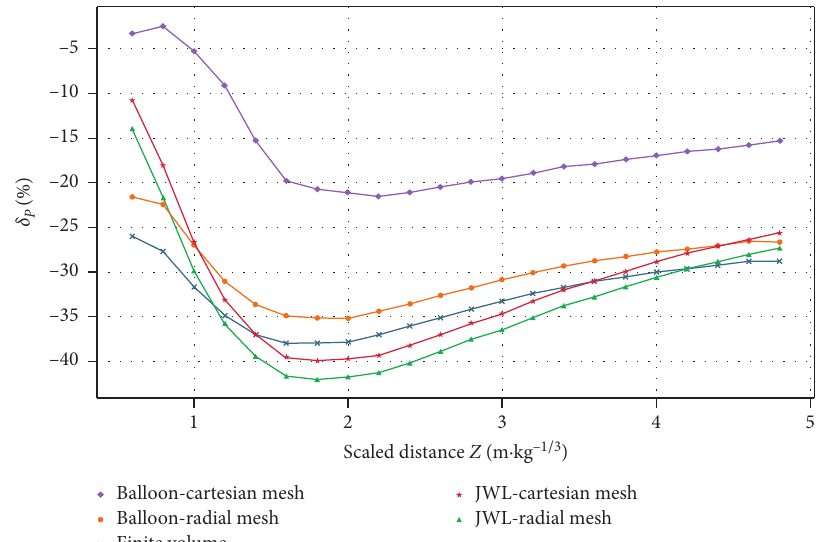
Figure 2: Relative difference with UFC-3-340-2 for impulse δ